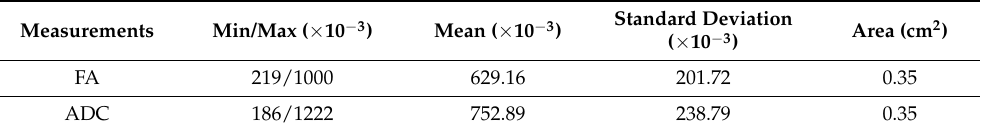
Table 5. Preliminary data obtained from our initial incomplete study, showcasing FA and ADC ROI scores of a healthy recruit. Data obtained through a standardisation protocol of DTI using 3T MAGNETOM PRISMA MRI scanner with a rFOV ZOOMit sequence with 4 averages (dynamic excitation for selective centrally excited field of view). We expect FA to be lower in recruits with DCM.